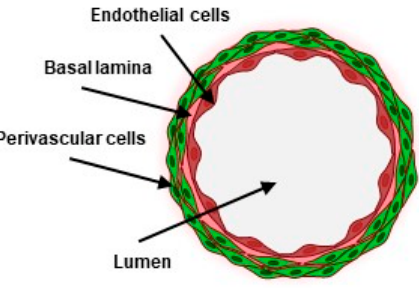
Figure 1. Schematic transversal view of a blood vessel (created with BioRender.com). Blood vessels participate in fundamental physiological processes. During inflammation and under the stimulation of pro-inflammatory cytokines, endothelial cells become activated and, consequently, strongly express leukocyte adhesion molecules at their luminal face that favor the rolling, arrest, firm adhesion, and extravasation of immune cells from the circulation toward the tissues [2]. Permeability is another important vascular function which is subsequent to the disruption of endothelial tight and adherens junctions [3]. Vascular permeability is impaired in several pathologies such as inflammation, oedema and ischemic stroke [4–6]. In human cancers, weak endothelial cell–cell junctions in the tumor vasculature create gaps and leaky vessels [7] that enable metastatic cancer cells to enter the circulation. Furthermore, the tumor blood vessel endothelium, while being imperfectly tight, actively protects tumor cells from the infiltration of circulating cytotoxic immune cells into the tumor mass through its barrier function [8–11].